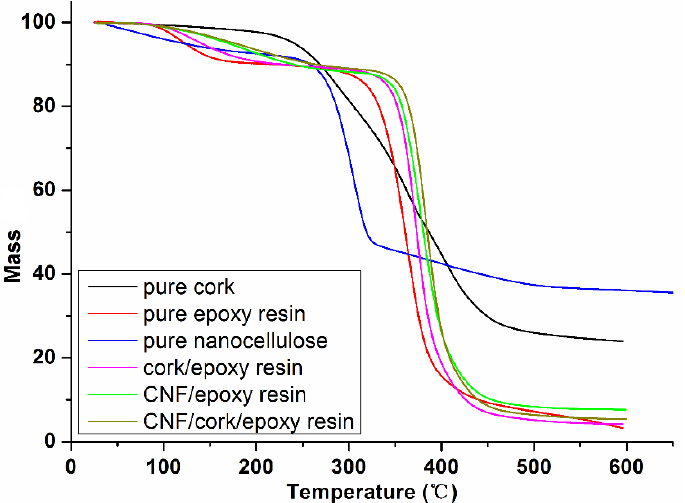
Figure 8. Thermogravimetric curves of the CNF/cork/epoxy resin composites.